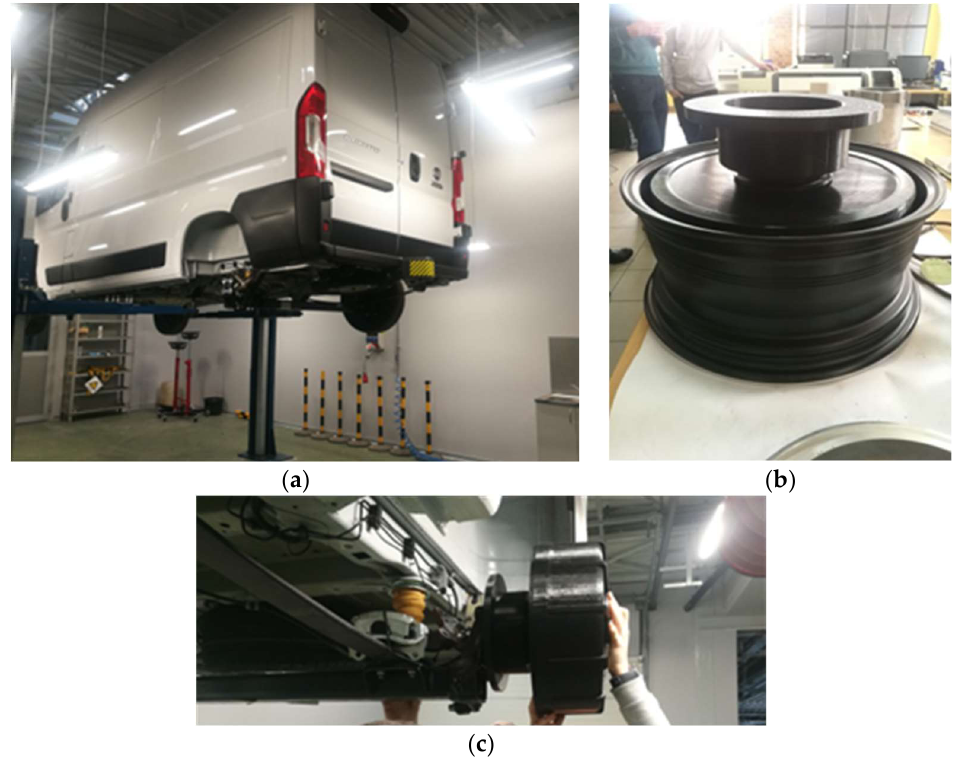
Figure 1. Fitting 3D printed model of motor: ( a ) Fiat Ducato car; ( b ) in the rim; ( c ) at the drive axle.